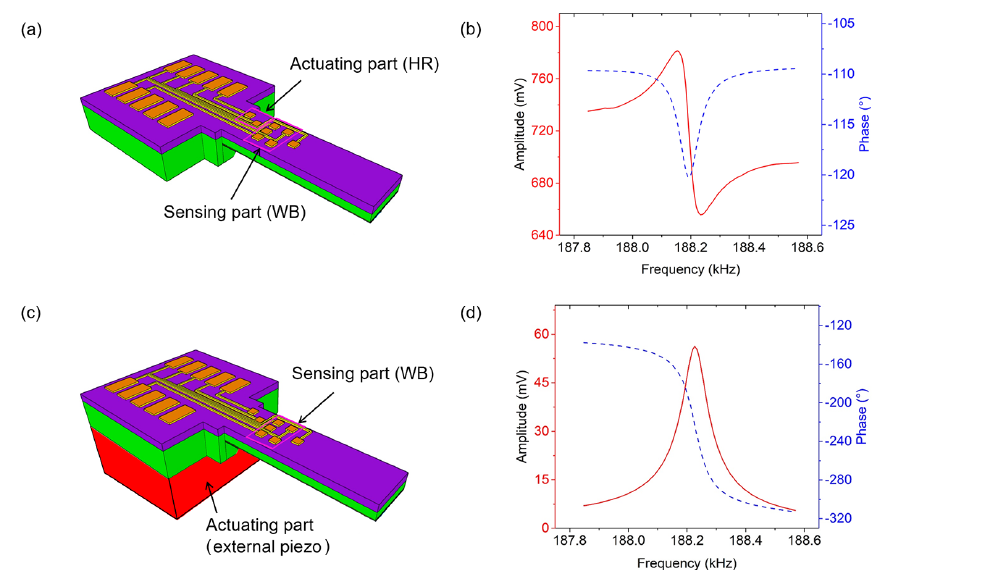
Figure 1. (a) Schematic of a thermally actuated cantilever sensor yielding (b) an asymmetric amplitude (red, full) and reversed phase response (blue, dashed). (c) Schematic of the same cantilever sensor actuated by an external piezoelectric shear actuator (HR disabled) yielding (d) a symmetric amplitude (red, full) and monotonic phase response (blue, dashed).